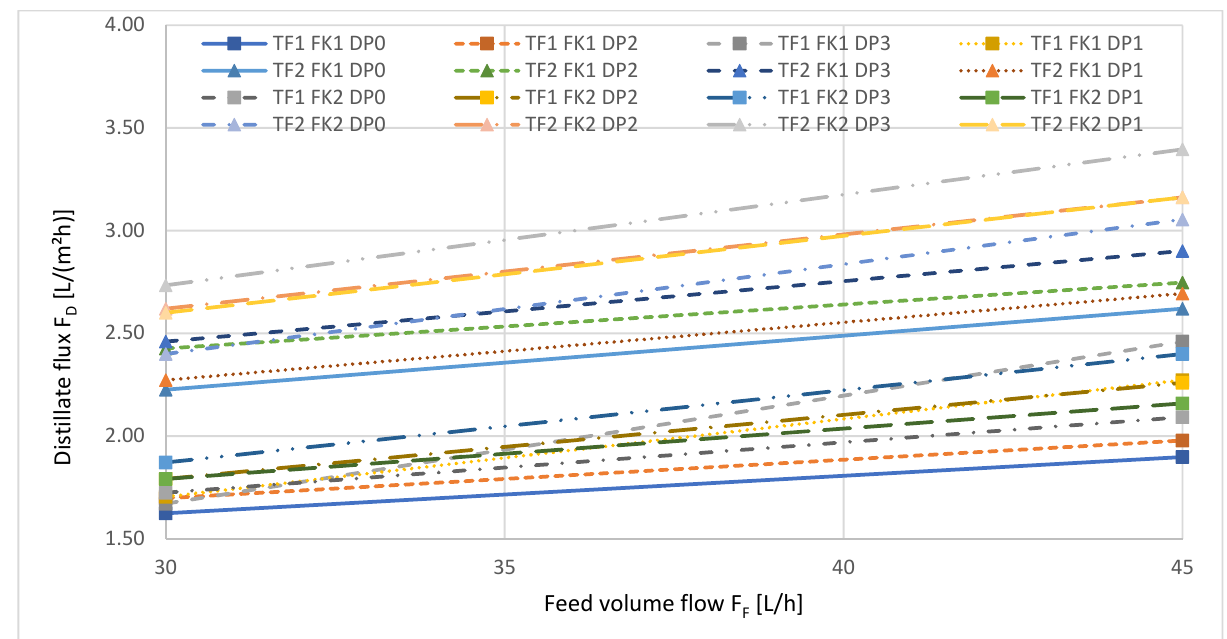
Figure 9. Distillate flux as a function of the feed volume flow (crossflow) during VMD. Δ p = const., T F = const., F K = const. during the respective measurement series. The numbers refer to the different reference levels, without pressure (0), low (1), medium (2) and high (3), described in Table 4.